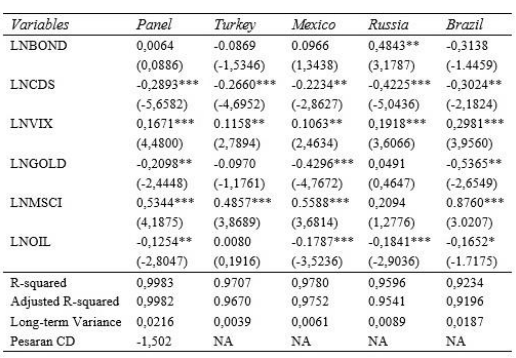
Table 7: LNSTOCK Long-term